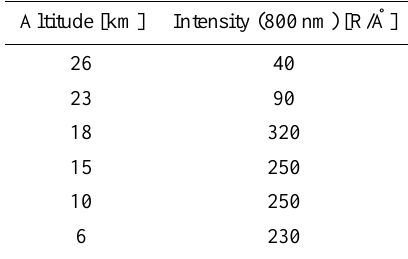
Table 1. Estimated emission height profile at 800nm from the OSIRIS instrument on the Odin satellite, orbit #9726, 6 December